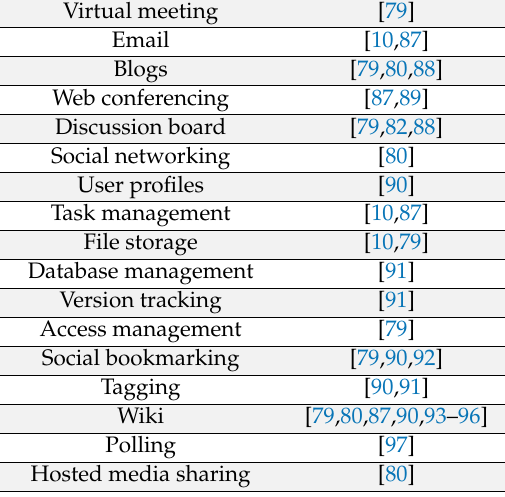
Figure 5. Types and percentages of adopted tools in the collected papers. Table 10. Examples of adopted tools and corresponding references